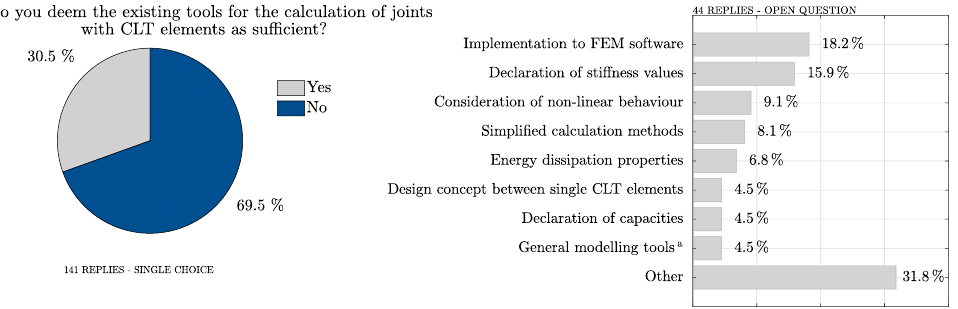
Figure 12. Potential improvements for cross laminated timber (CLT) connection